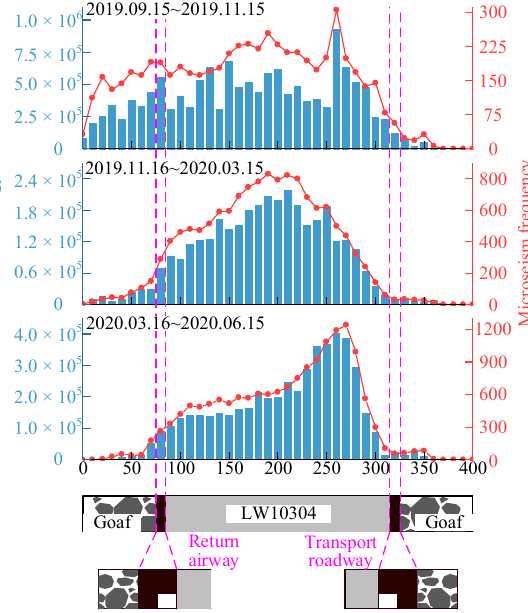
Figure 6. The spatial distribution of microseism energy and frequency in the inclination direction.